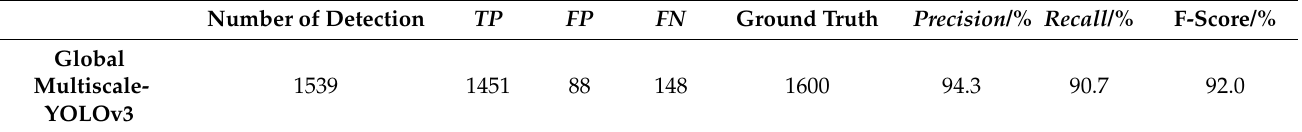
Table 6. Global Multiscale-YOLOv3 detection